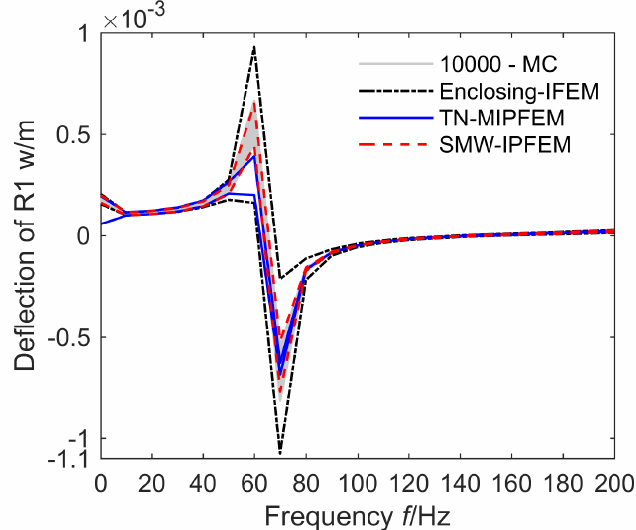
Figure 12. The sound pressure at the point of R1.